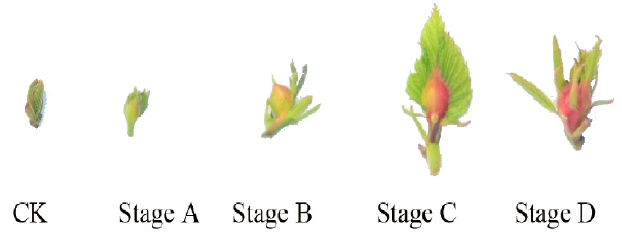
Figure 1. Development stages of gall formation produced by D. kuriphilus infestation. CK: A healthy leaf used as